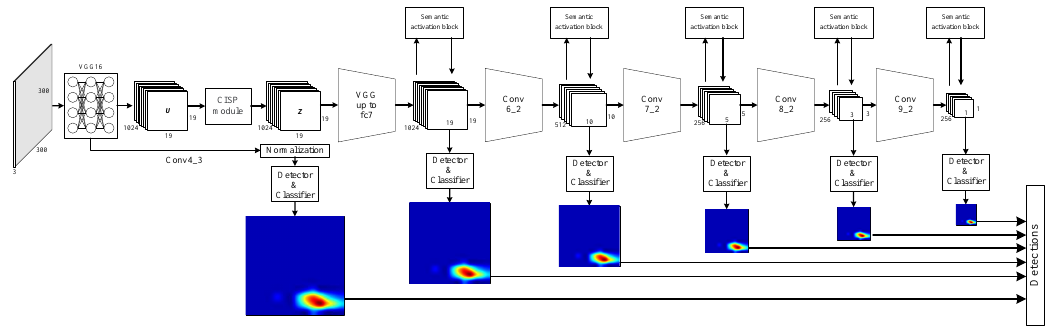
Figure 1. Context Perception-Single Shot MultiBox Detector (CP-SSD) network